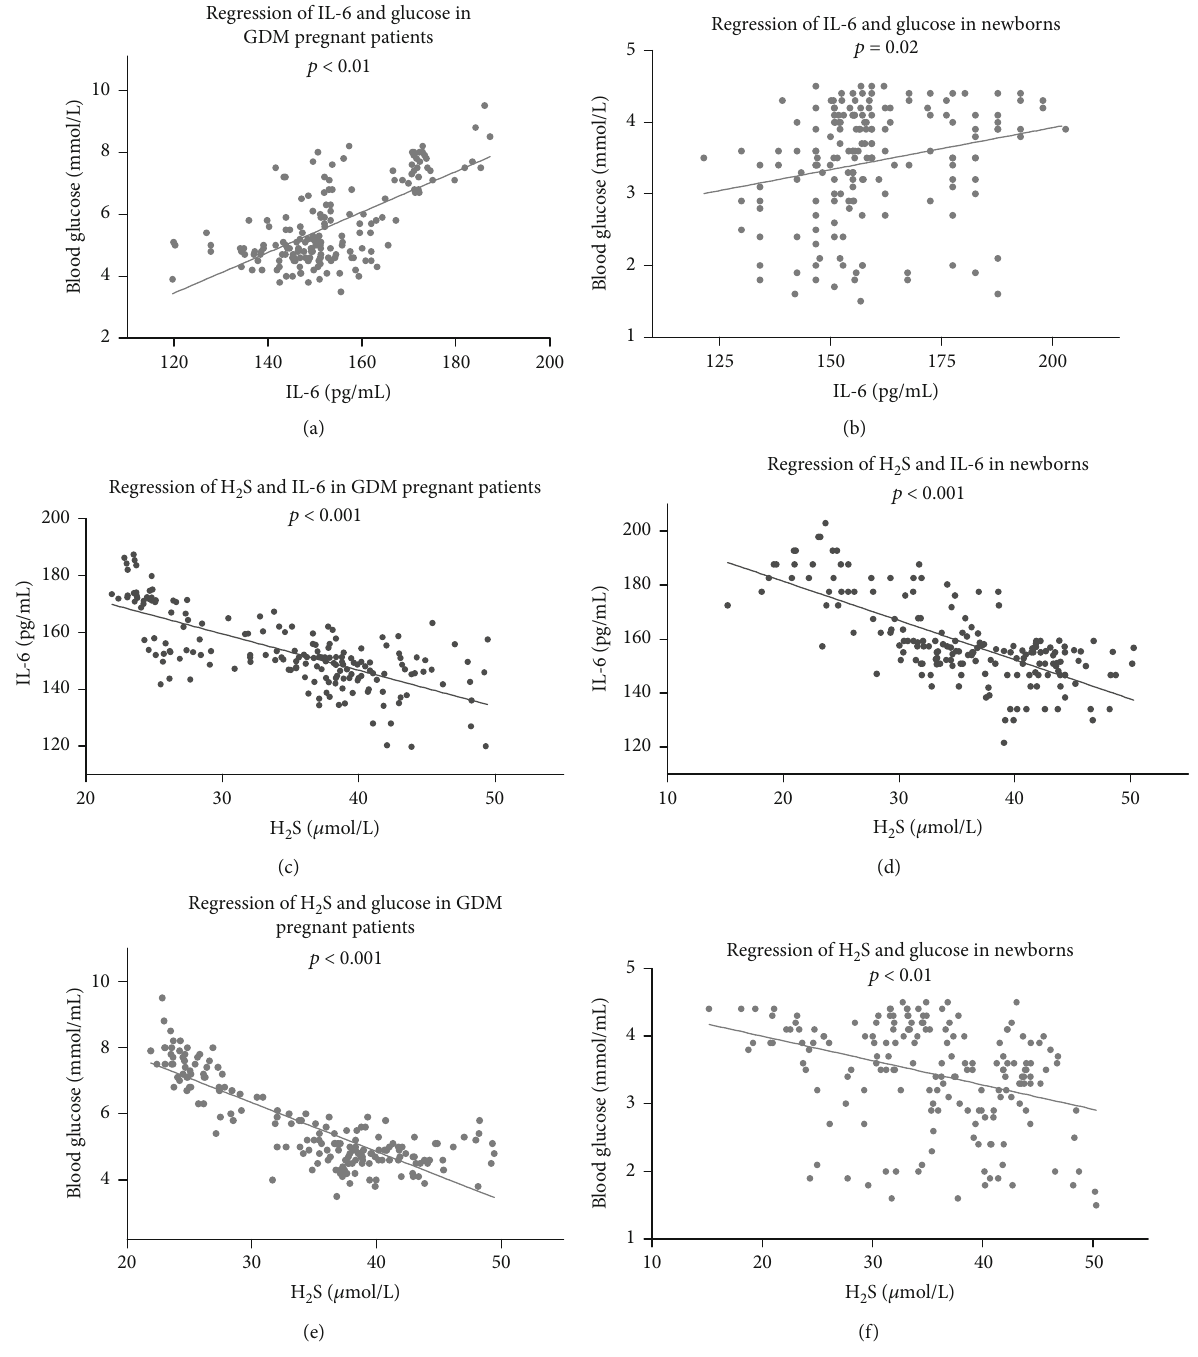
Figure 5: The concentration of H S in fl uenced the glucose and IL-6 levels in GDM patients. (a) The levels of IL-6 and blood glucose were 2 positively correlated. (c, e) The concentration of H S was negatively correlated with levels of IL-6 and glucose. (b) IL-6 and glucose were 2 S was negatively correlated with IL-6 and glucose in newborn positively correlated in the UVB of newborns. (d, f) H 2